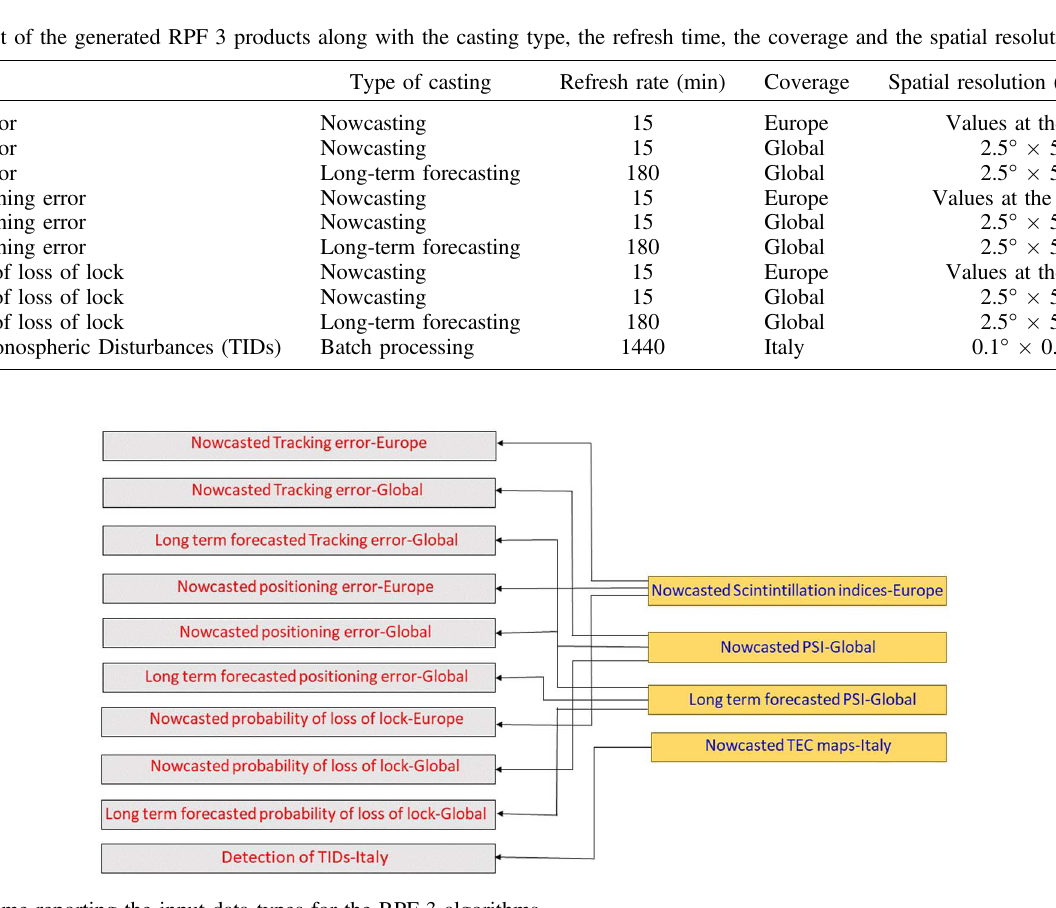
Fig. 4. Scheme reporting the input data types for the RPF-3 algorithms.